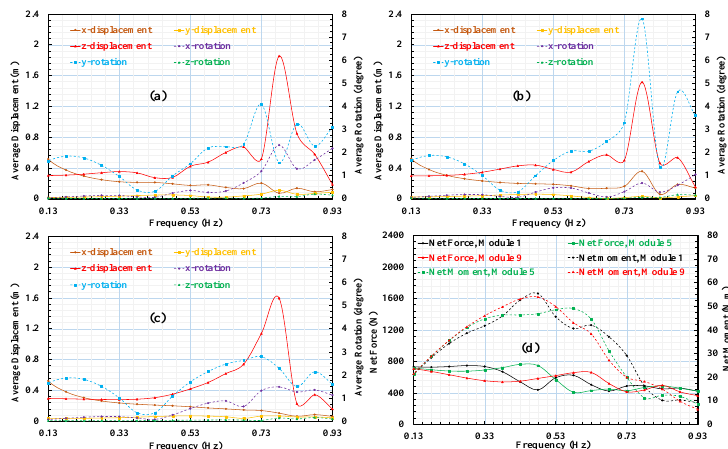
Figure 12. Average displacement of ( a ) module 1, ( b ) module 5, ( c ) module 9, and ( d ) net forces and moments corresponding to 180 ◦ of the wave direction.